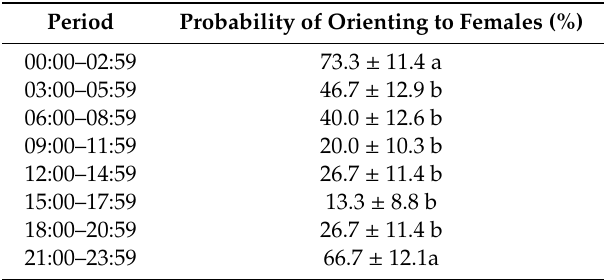
Table 1. The probability of males being attracted to females in eight di ff erent time periods. Period